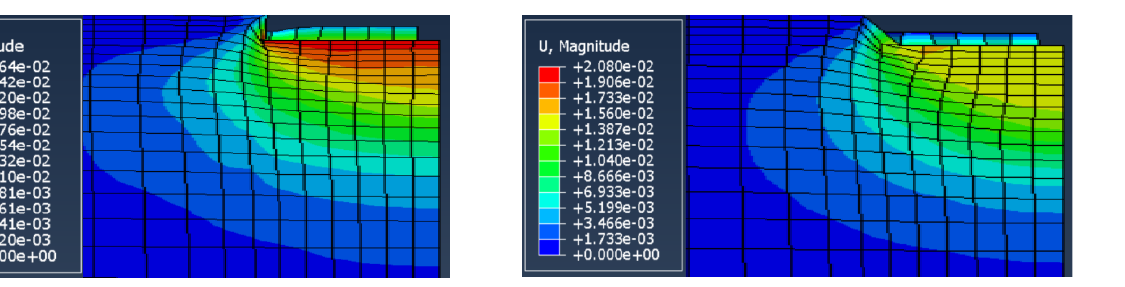
Figure 26 : Displacement contours of case 1 at h/B = 2.275 for L/B=1. Figure 27 : Displacement contours of case 8 at h/B = 2.275 for L/B=1.